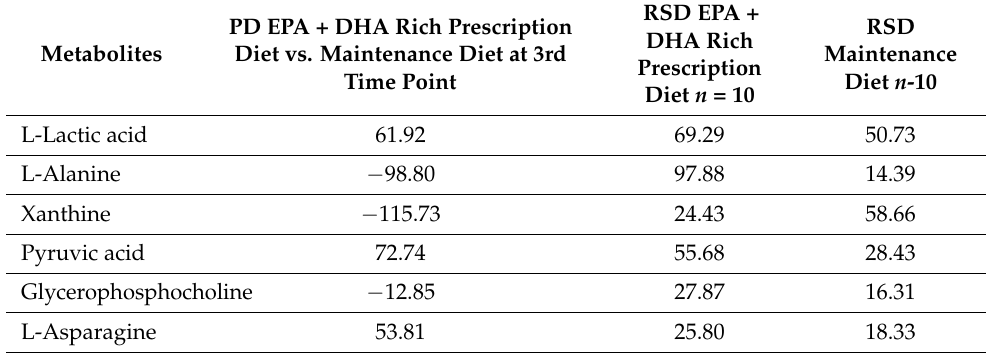
Table 8. List of metabolites at 3rd time point (6 months) selected by VIP model with their percentage difference and relative standard